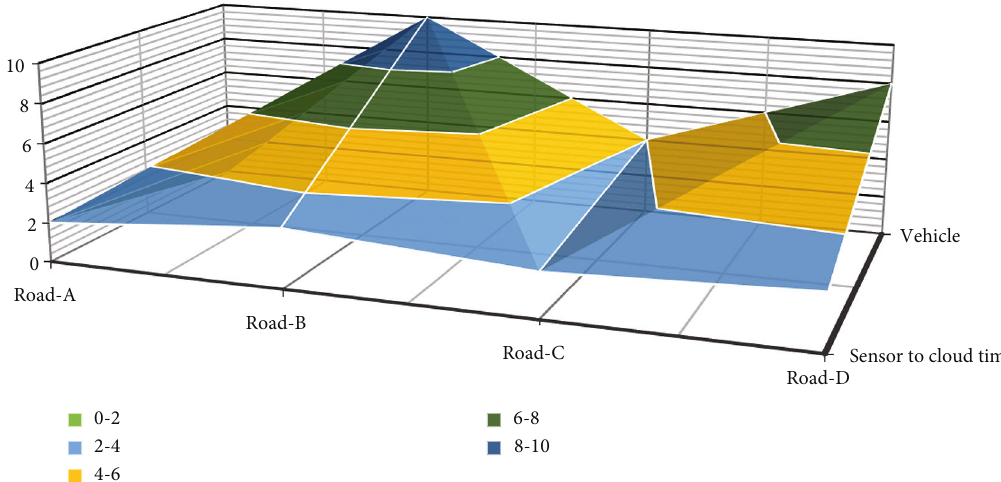
Figure 7: Road vise total sync time (sensor — Google Map) and (sensor — signal